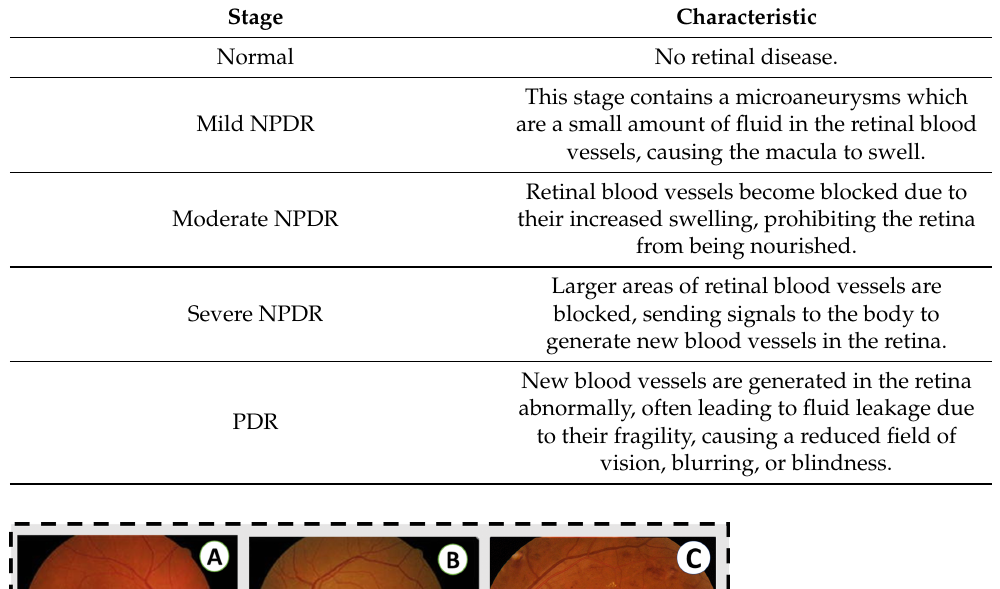
Table 1. Characteristics of the DR stages.